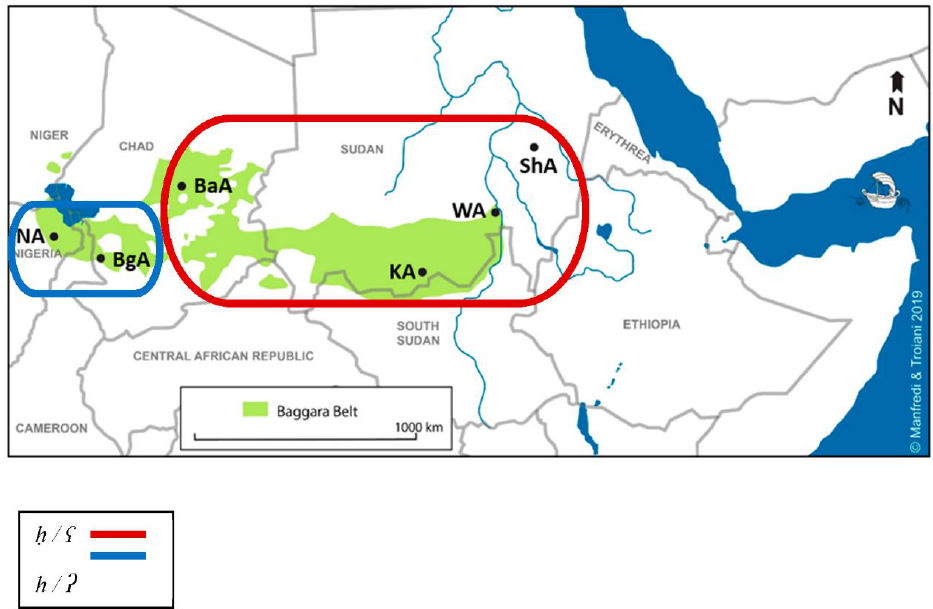
Figure 3. Depharyngealization.